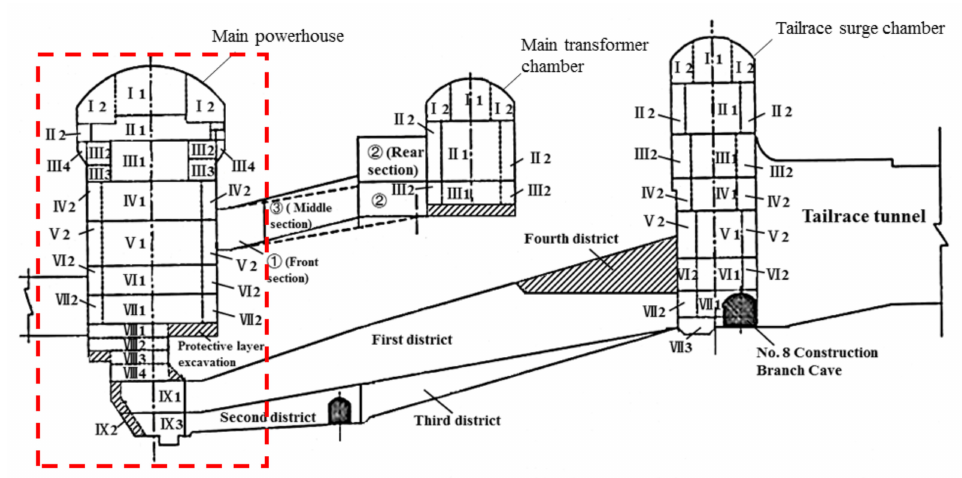
Figure 2. Schematic diagram of stratification and sectional cross-section of underground cavern group in Pubugou Hydropower